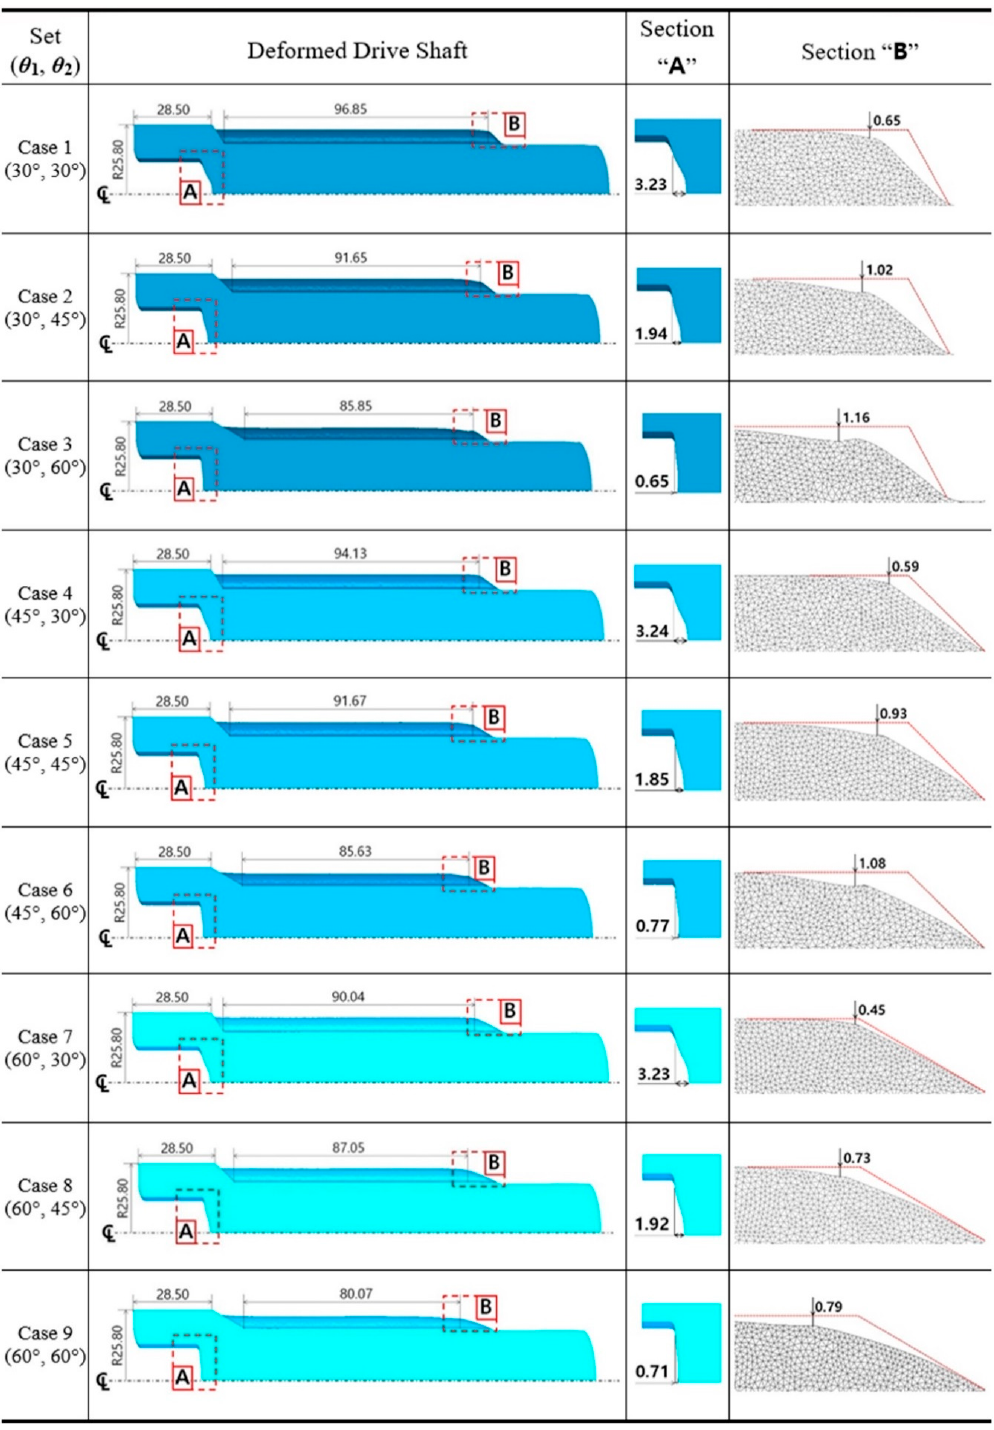
Figure 11. Geometric evaluation of the drive shaft obtained from the combined extrusion (unit: mm).